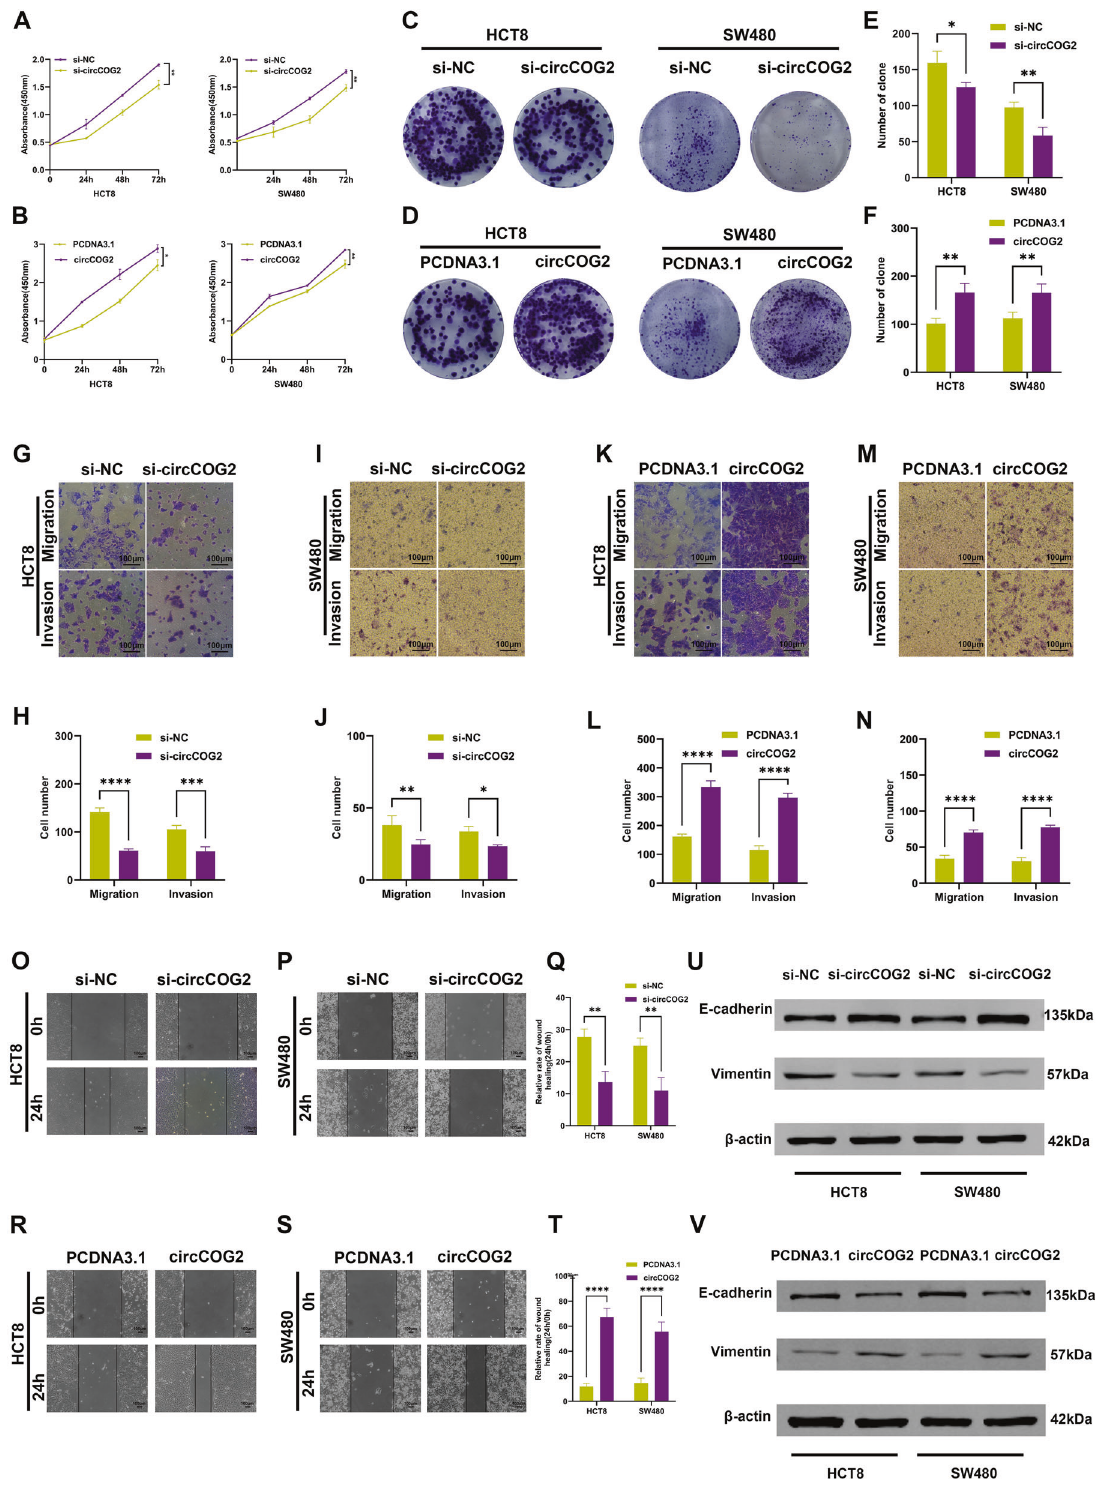
Fig. 2 circCOG2 promotes CRC proliferation, migration, and invasion in vitro. A , C and E CCK8 and colony formation assays indicated that knockdown of circCOG2 inhibited CRC cells proliferation. B , D and F CCK8 and colony formation assays indicated that overexpression of circCOG2 promoted CRC cells proliferation. G – J Transwell assay indicated that knockdown of circCOG2 inhibited CRC cells migration and invasion. K – N Transwell assay indicated that overexpression of circCOG2 promoted CRC cells migration and invasion. O – Q Wound healing assay indicated that knockdown of circCOG2 inhibited CRC cells migration. R – T Wound healing assay indicated that overexpression of circCOG2 promoted CRC cells migration. U Western blot showed that the expression of vimentin and E-cadherin was decreased and increased, respectively, in CRC cells with circCOG2 knockdown. V Western blot showed that the expression of vimentin and E-cadherin was increased and decreased, respectively, in CRC cells with circCOG2 overexpression. * P < 0.05; ** P < 0.01; *** P < 0.001; **** P < 0.0001; P -values were calculated by Student ’ s t -test. Cell Death Discovery (2021)